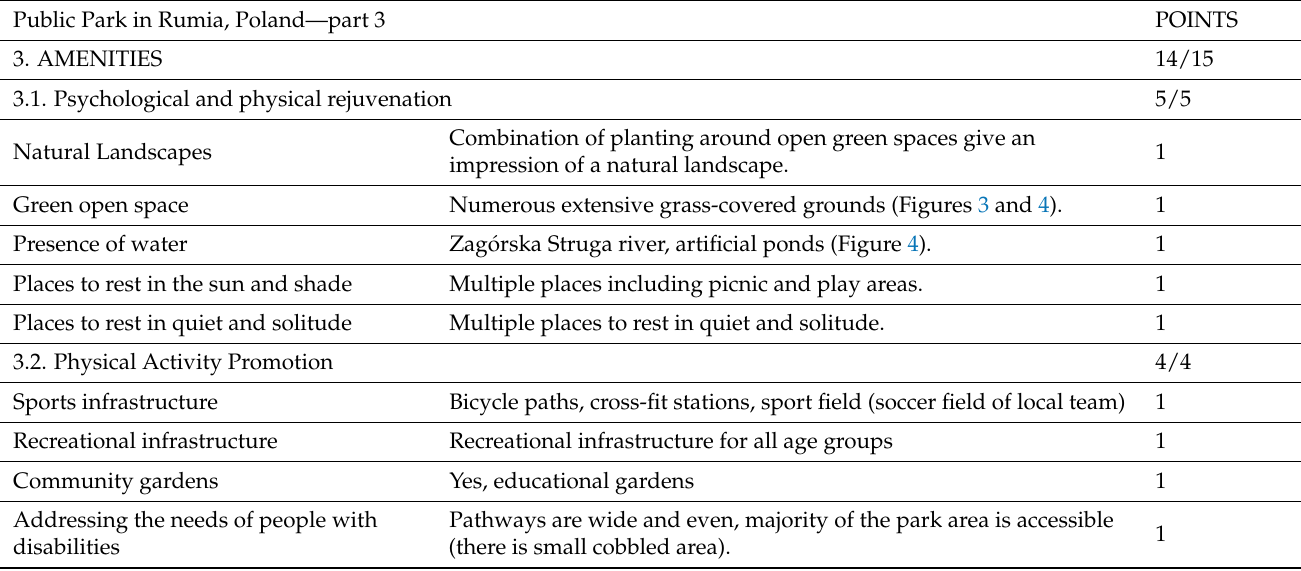
Table 3. Assessment of Public Park in Rumia, Poland—part 3, source: